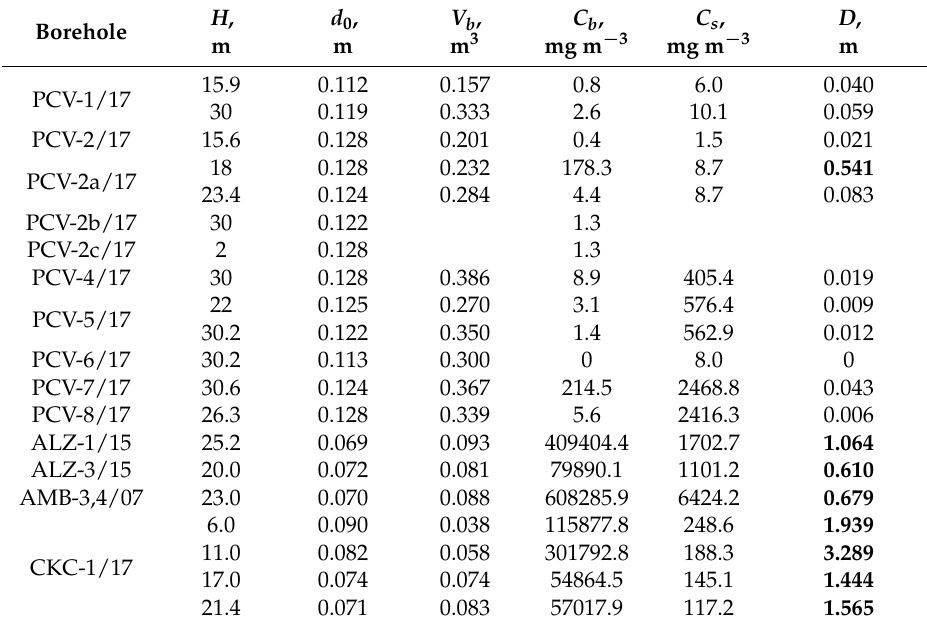
Table 1. Concentration of methane in boreholes C b and its relation to the concentration C s of methane in permafrost as measured in the core, and the equivalent diameter of degassing D of permafrost around the borehole to meet the concentration of methane observed inside the hole. The diameters exceeding the weighted average diameter of the borehole d 0 are marked in